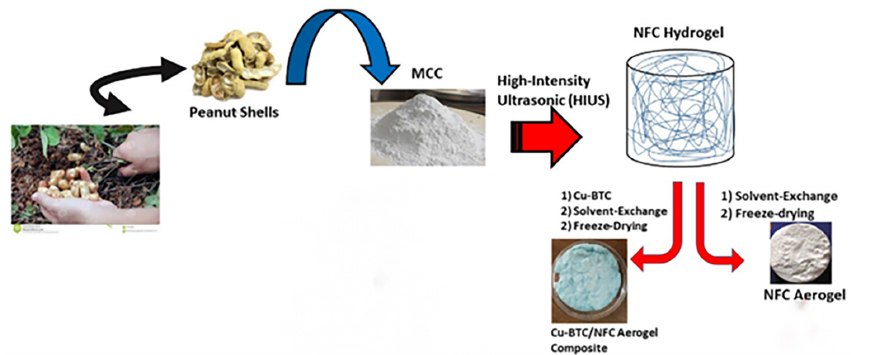
Figure 1. Synthesis of pure NFC aerogel and Cu-BTC/NFC aerogel [66] by Nuhaa Shaheed, used under CCBY4.0/Cropped from original.